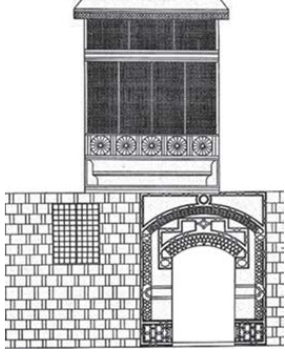
Figure 9-3 windows of Bayt el Suhaymi Figure 9-4 ceiling of Bayt el Suhaymi